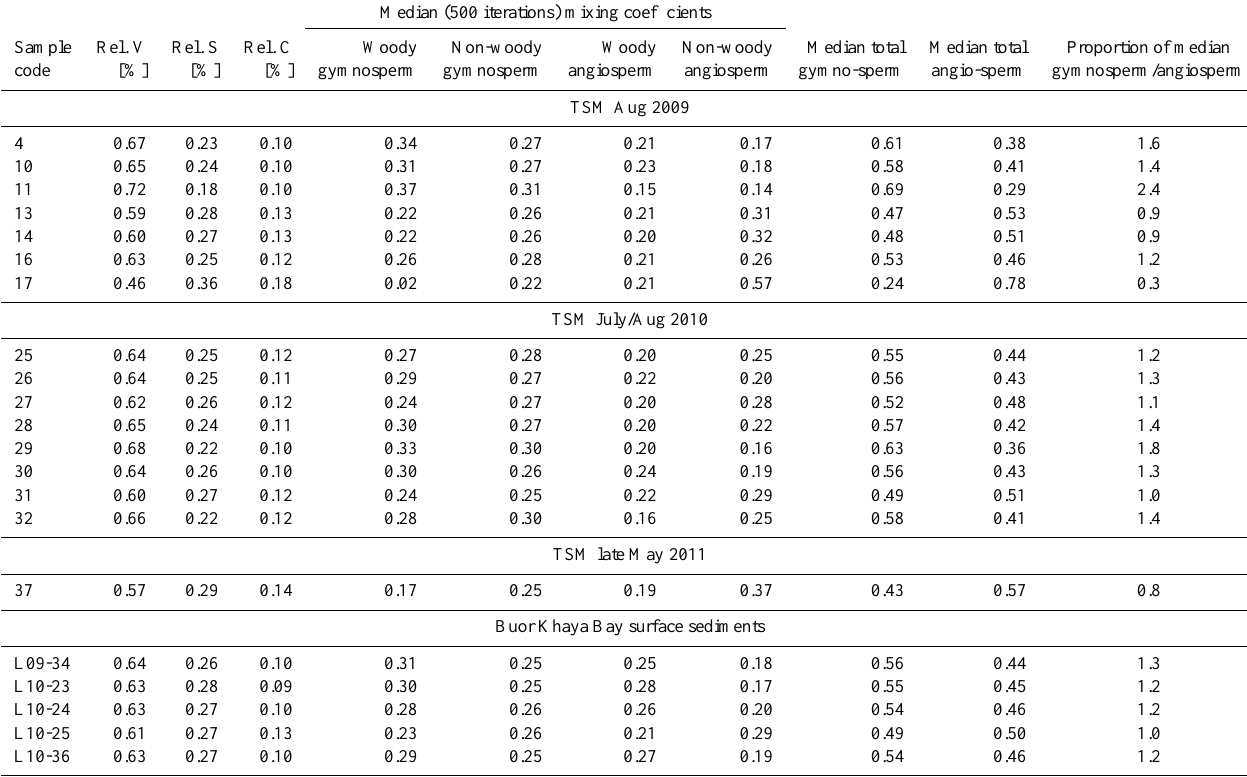
Table 7. Results of unmixing model including relative abundances of V, S, and C phenols; median mixing coefficients; and gymnosperm to angiosperm ratio. See Tables 4 and 5 for